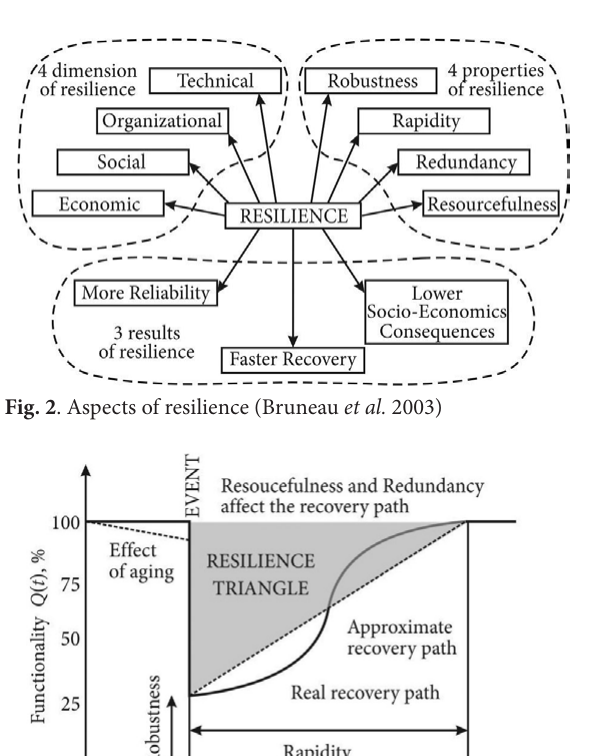
Fig. 1. Example of Eco profile to represent Environmental Impacts of Buildings (Peuportier 2001)